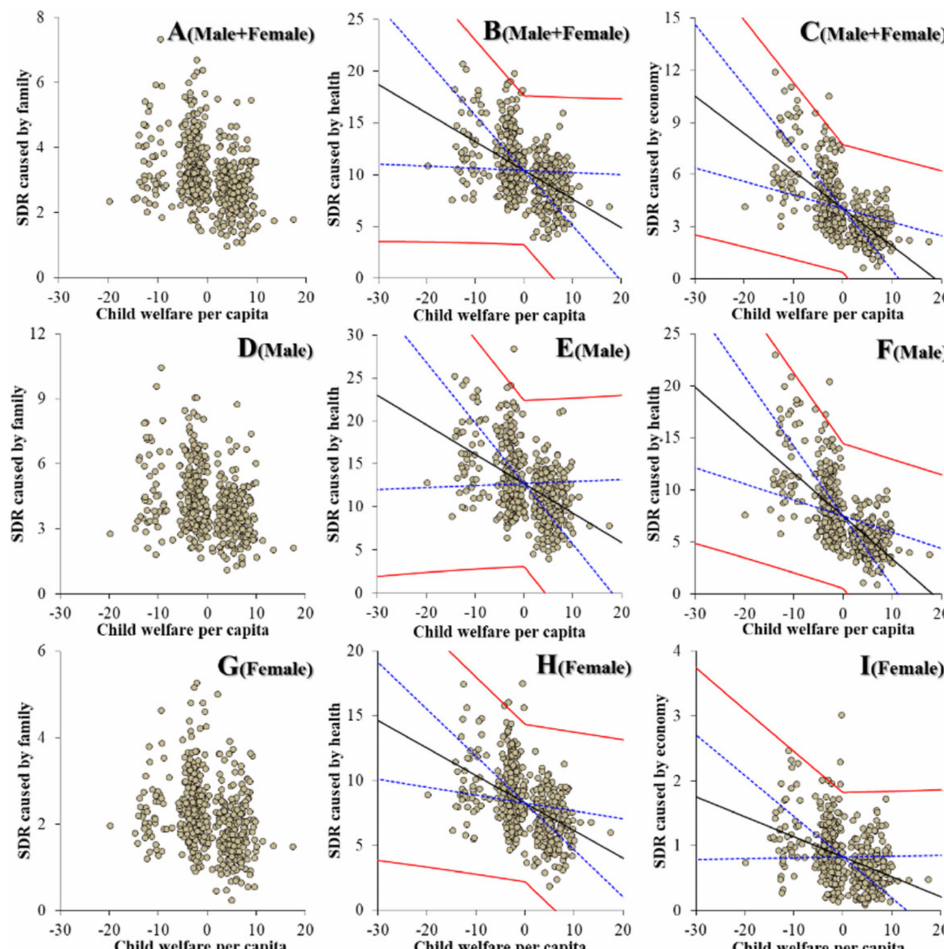
Figure 7. Relationship between financial expenditure per capita on child welfare of prefectures and municipalities, and suicide mortalities of males + females ( A – C ), males ( D – F ) and females ( G – I ) caused by motives associated with family ( A , D , G ), health ( B , E , H ) and economy ( C , F , I ), and suicide mortality of both genders (males + females) caused by family ( A , D , G ), health ( B , E , H ) and economy ( C , F , I ) from 2009 to 2018 using fixed- or random-effect analysis of hierarchal linear regres- sion with robust standard error. Ordinates and abscissas indicate SDR of suicide mortalities (per 100,000 population) and centralised (by average) social welfare expenditure per capita of prefectures plus municipalities (JPY 10,000), respectively. Black, blue and red lines are the slope of fixed effects, standard deviation of fixed effects and fixed effects with random effects,